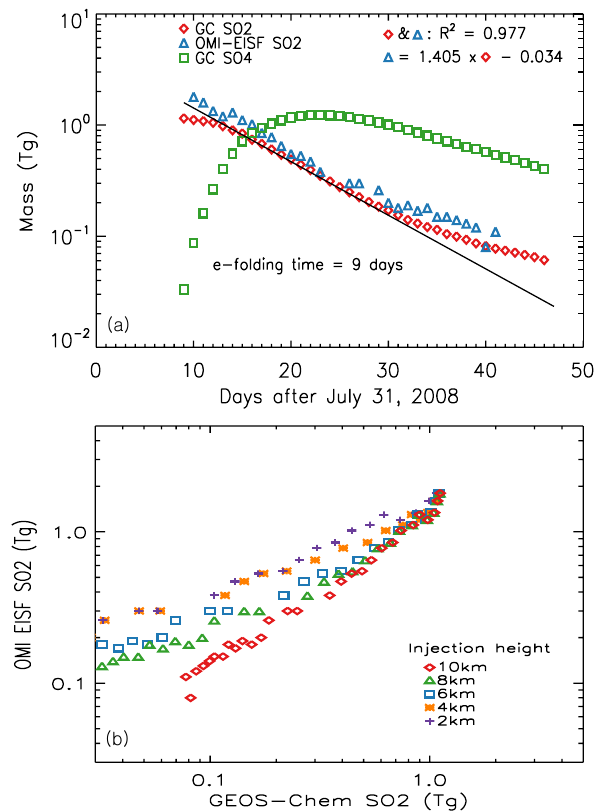
Fig. 3. (a) Time series of daily total volcanic SO 2 mass (in log-scale on y-axis) after the Kasatochi eruption. Red diamonds and blue tri- angles are the results from the GEOS-Chem simulation and OMI retrievals, respectively. Also overlaid is the GEOS-Chem simulated total volcanic SO 2 − mass (green squares). The solid black line is 4 a linear least-squares-fit between the GEOS-Chem simulated SO 2 mass (log scale) and the number of days after the eruption, from which an e-folding time of 9 days for SO 2 is derived. Also shown at the top right is the equation for a linear least-squares-fit between GEOS-Chem simulated and OMI retrieved SO 2 as well as their lin- ear correlation coefficient ( R ). (b) Scattered diagram of daily to- tal volcanic SO 2 mass between GEOS-Chem (with each injection height) and OMI retrievals. Note, the time series of OMI SO 2 data is obtained from Krotkov et al. (2010), in which the data points in the first two days are estimated based upon the extrapolation to ac- count for OMI’s sampling bias due to limited spatial and temporal